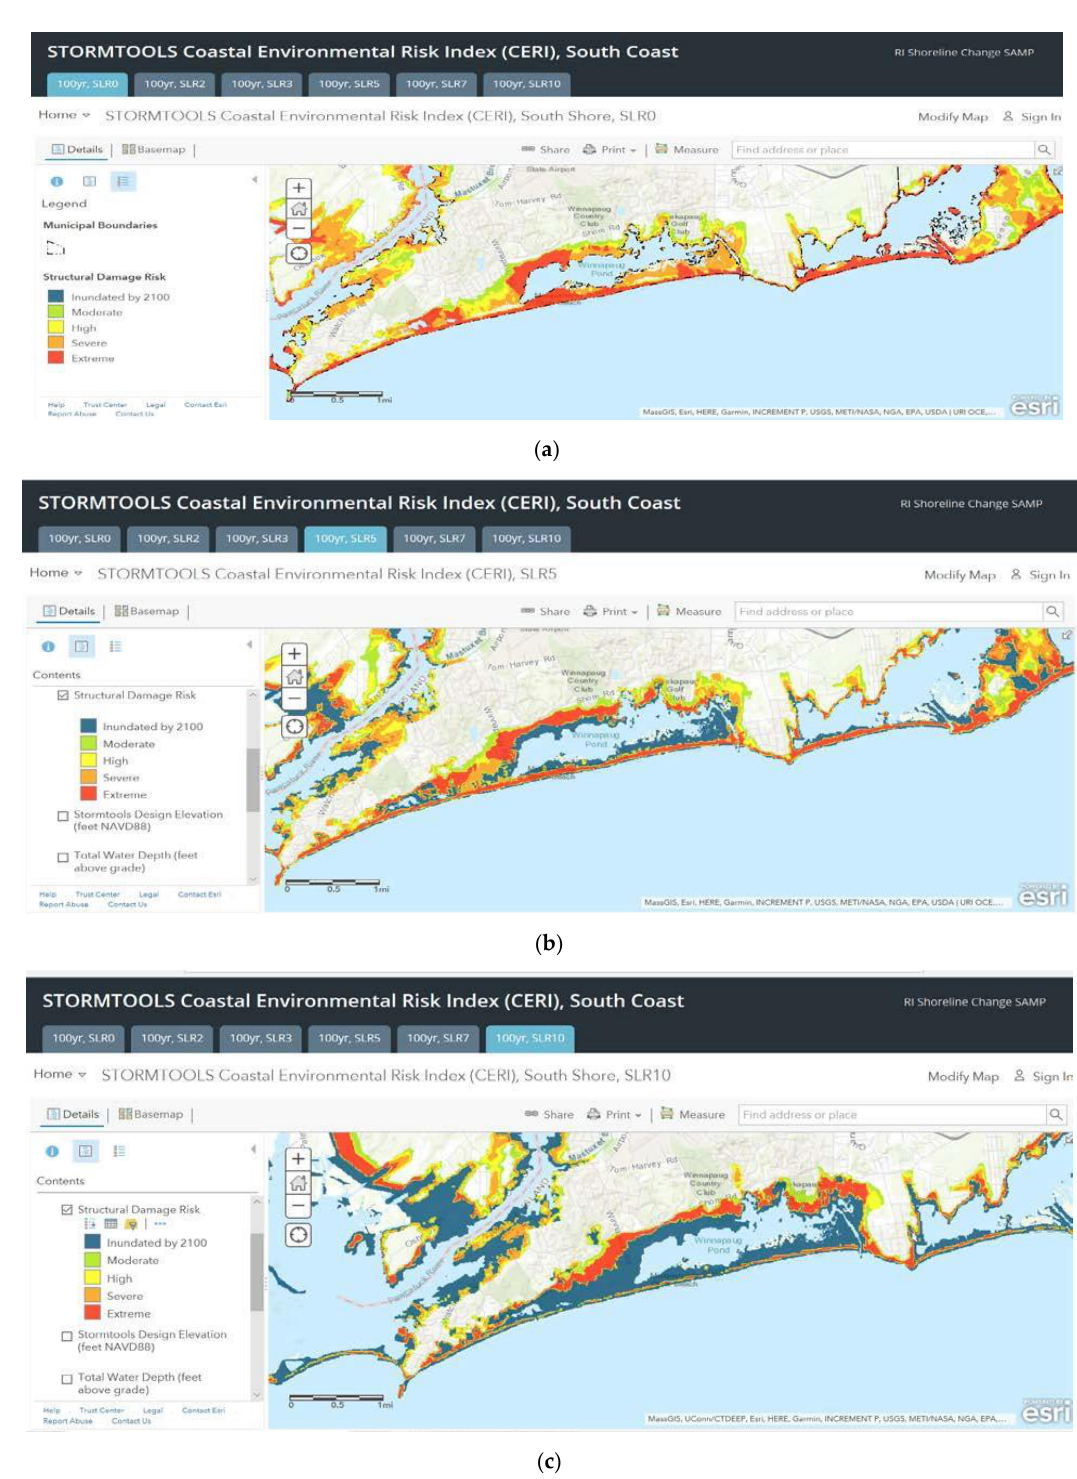
Figure 13. CERI predicted damage and risk maps for 100 yr surge with 5 ft of SLR.